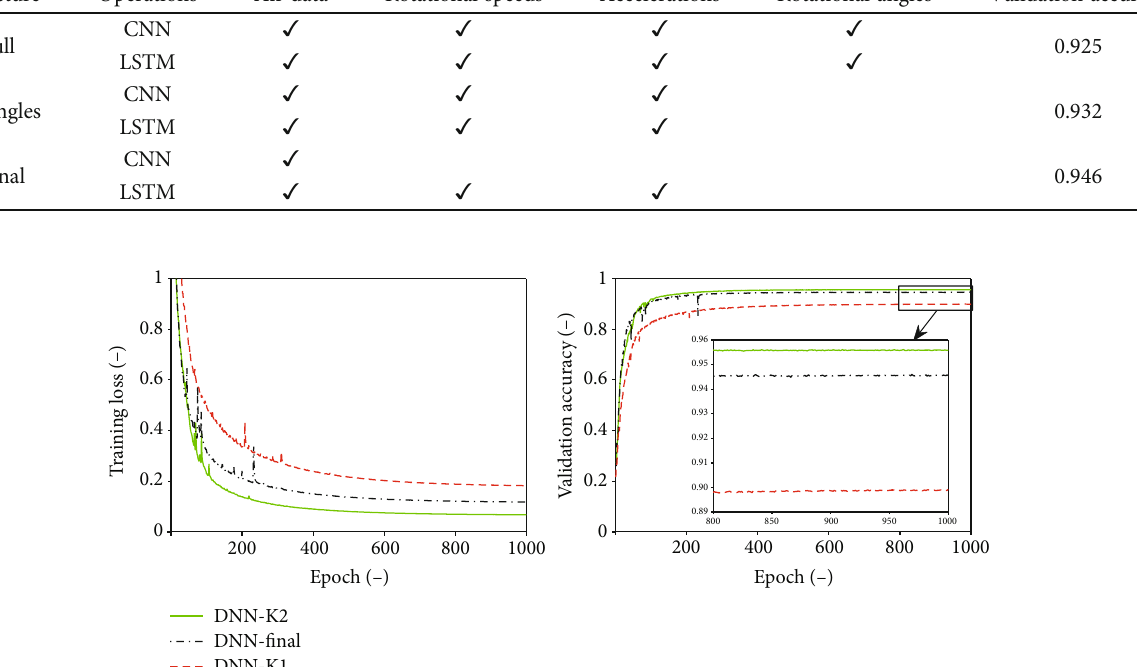
Figure 7: Studies on di ff erent CNN kernel sizes. The results are summarized from the training of DNN- fi nal (kernel size 3 × 3 ), and 2 descendent architectures of DNN- fi nal, i.e. DNN-K2 (kernel size tweaked as 2 × 2 ) and DNN-K1 (kernel size 1 × 1